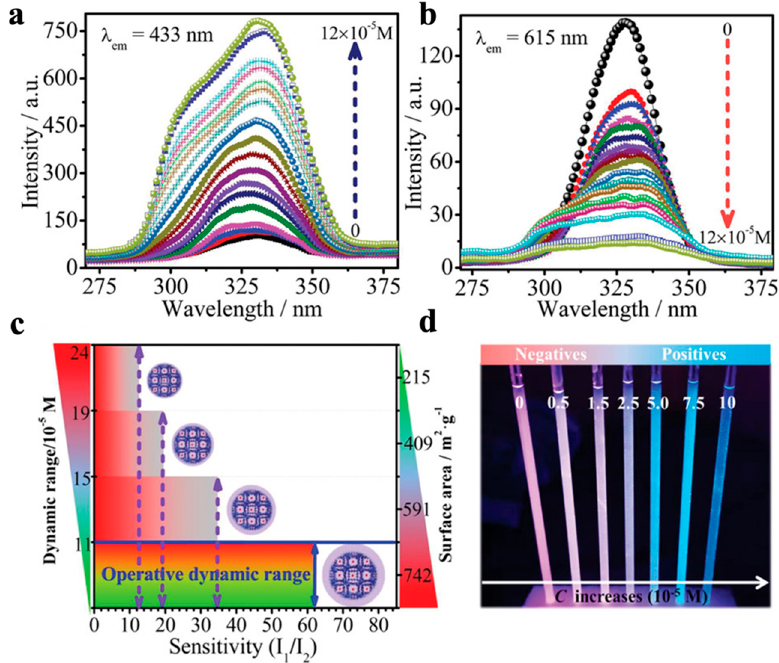
Figure 3. Ratiometric luminescence sensing of VMA by Eu-ZnMOF- n . ( a , b ) The widening of the excitation peak of Eu-ZnMOF- n, monitored at both 433 and 615 nm emissions with incremental addition of VMA. ( c ) The structure–property relationship of the probe’s surface area to its dynamic range and sensitivity. ( d ) Color-coded digital array of Eu-ZnMOF- n probe after treatment with increased VMA concentrations under irradiation with a UV lamp ( λ ex = 254 nm). [32] Copyright 2020, John Wiley and Sons.